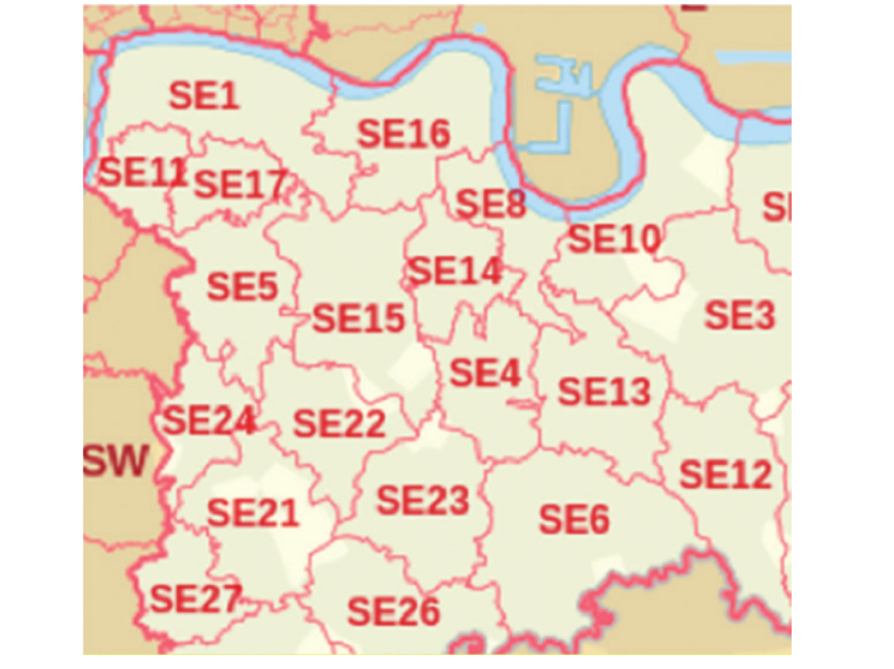
figure 7: Postcodes in lewisham surrounding and including Deptford (se8) (credit: Richardguk, contains ordnance survey and Royal Mail data © crown copyright and database right (2012), licence: cc BY-sa 3.0, https://en.wikipedia.org/wiki/file:se_